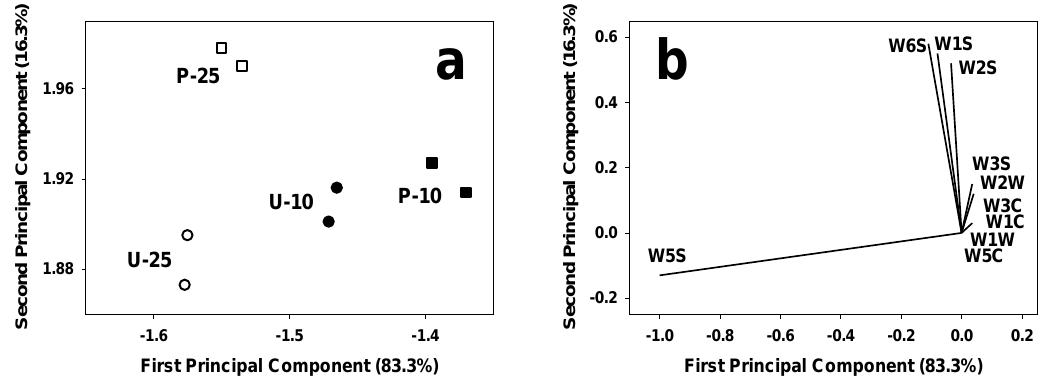
Figure 4. E-nose PCA score plot ( a ) and loading plot ( b ). Samples are identified by letters (indicating the use of untreated (U) or parboiled (P) rice) and digits (10, 25) indicating the percent content in soybean flour.